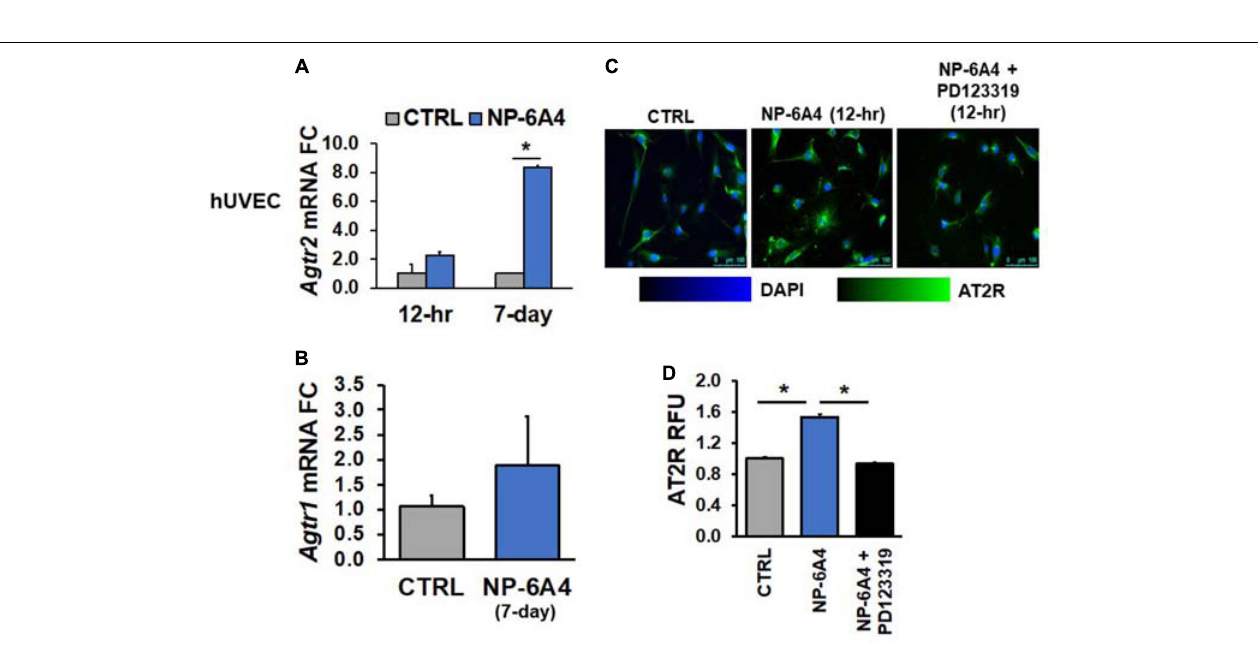
FIGURE 3 | NP-6A4 increased Agtr2 mRNA and AT2R protein expression in hUVEC. (A) 1 µ M NP-6A4 for 12-h showed no difference in Agtr2 mRNA, while 7-day treatment increased Agtr2 mRNA expression eightfold. (B) No change in Atgr1 was detected after 1 µ M NP-6A4 for 7-days. n = at least three biological replicates and PCR replicates, respectively, for these experiment. (C) Representative images of hUVECs treated with 1 µ M NP-6A4 for 12-h. Blue indicates DAPI stained nuclei and green AT2R. Merged images are shown for all experimental conditions. (D) Quantification of relative fluorescent units (RFU) shows increased expression of AT2R protein after 1 µ M NP-6A4 treatment for 12-h and 20 µ M PD123319 prevented this increase. Immunofluorescent experiments consisted of quantification of > 50 cells from triplicates per experiment. ∗ Indicates p < 0.05 using One-way ANOVA. hUVEC, human umbilical vein endothelial cell; FC, fold change.